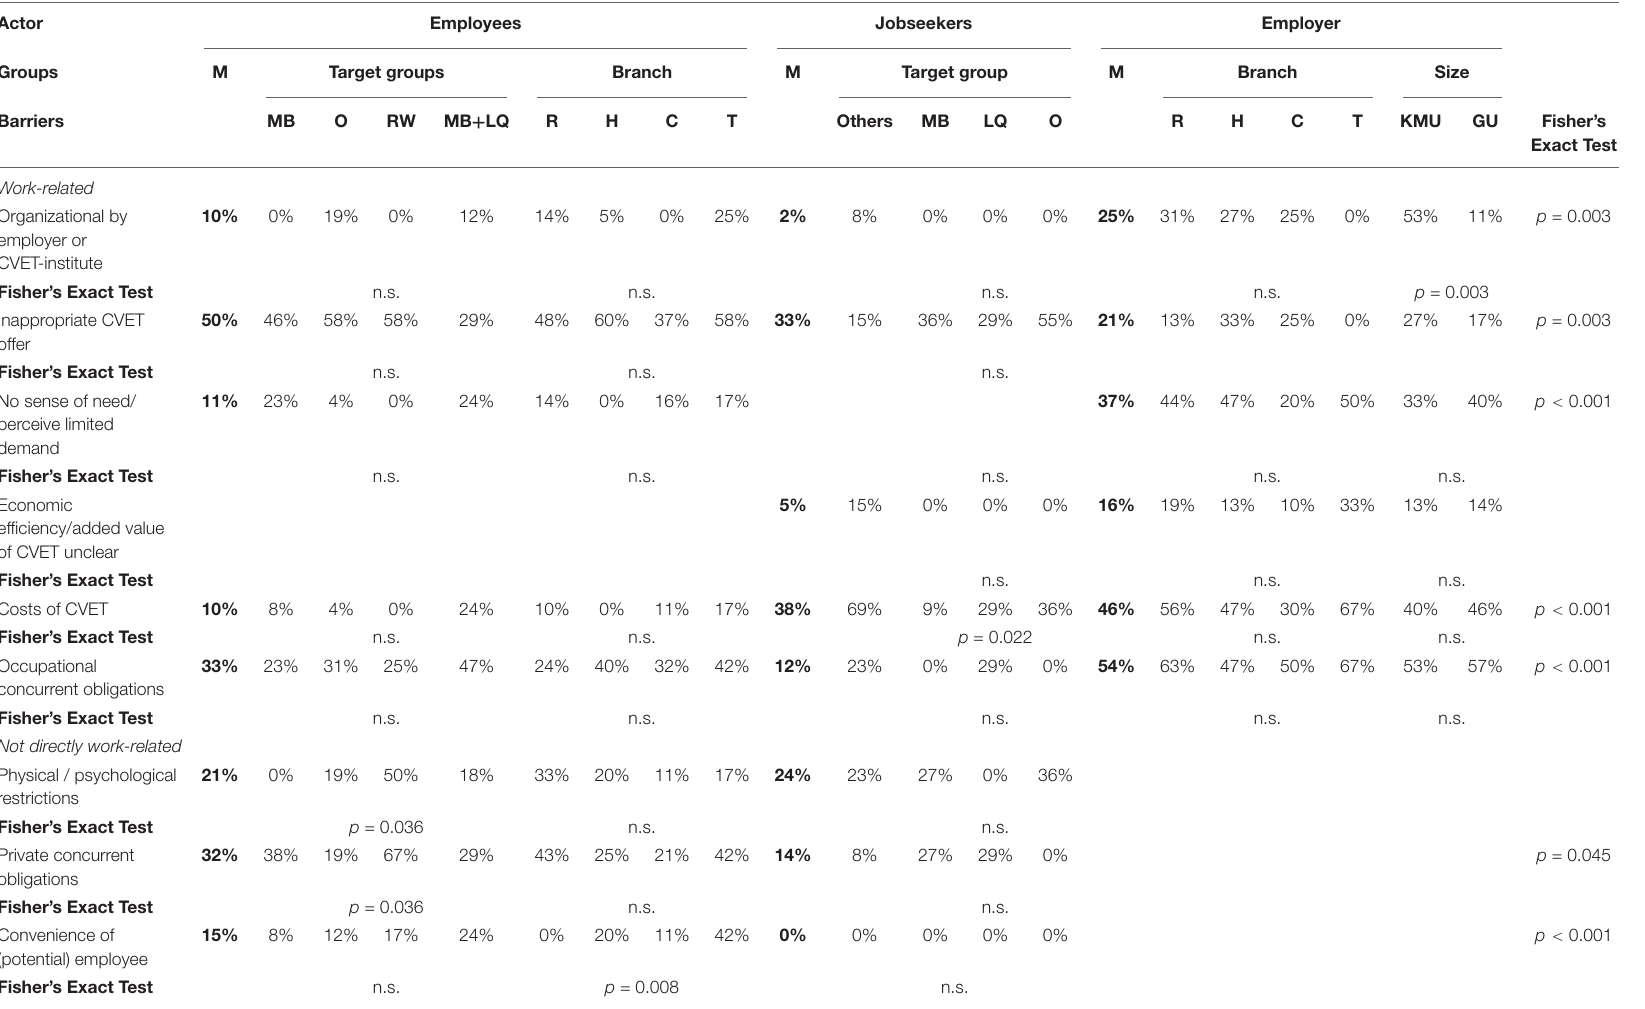
TABLE 5 | Barriers to attending and offering